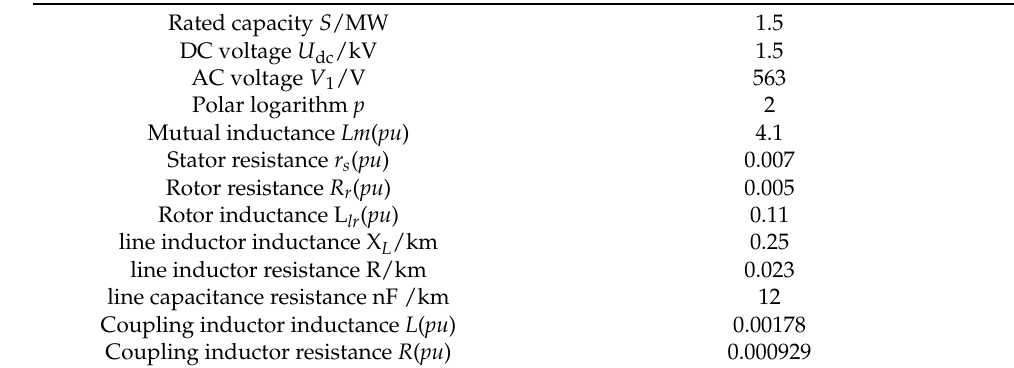
Figure 5. Two-zone power system with DFIG sliding-mode control. Table 1. Main parameters of the components.